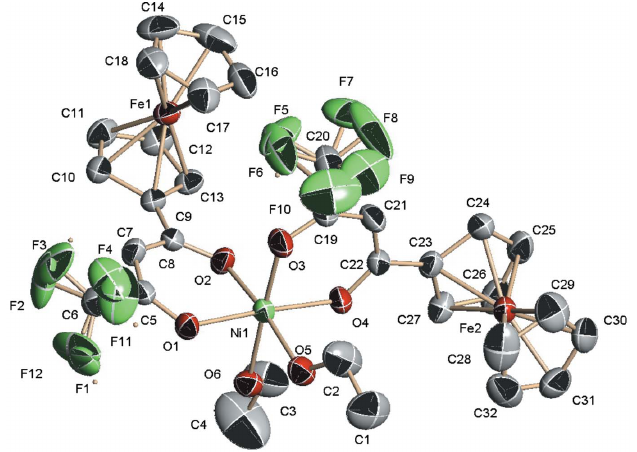
Figure 1 The molecular structure of the title compound, with the atom-numbering scheme. Displacement ellipsoids are drawn at the 30% probability level; H atoms were omitted for